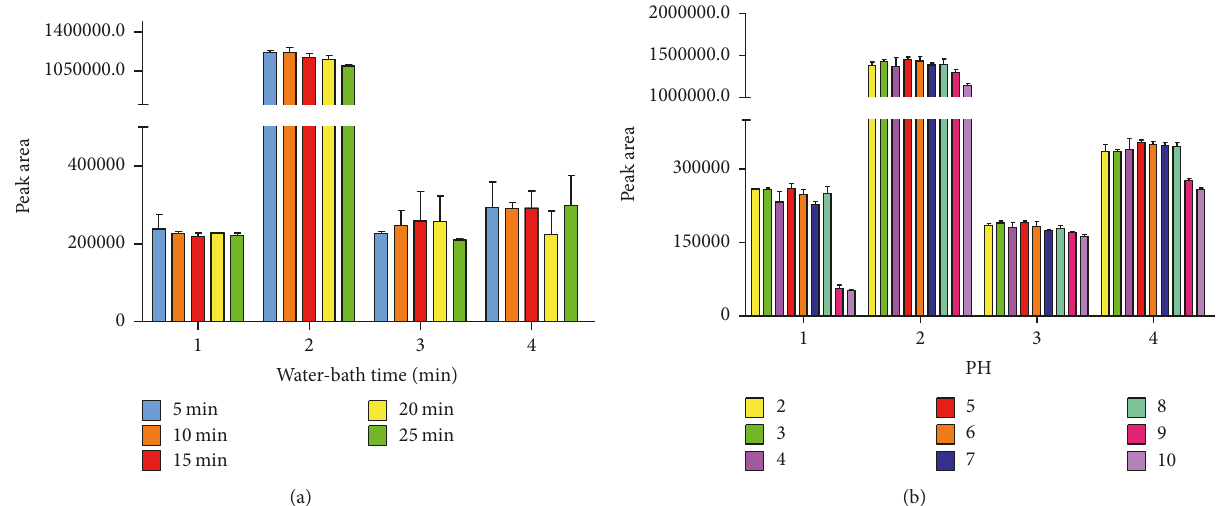
Figure 5: Effect of water-bath time (a) and pH of cloud point extraction (b) on the extraction effect of 4 components. 1, gallic acid; 2, bergenin; 3, quercitrin; 4,